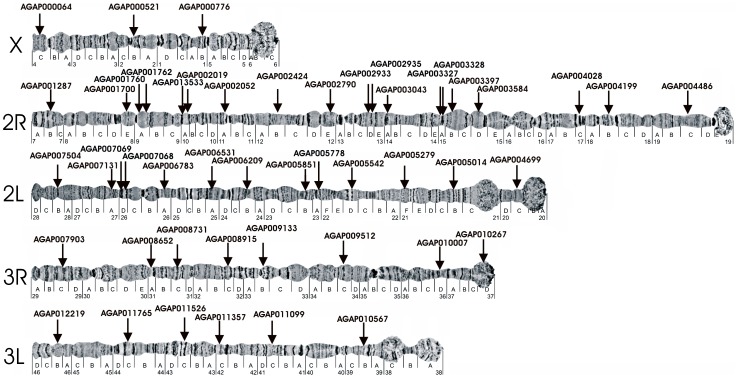
Distribution of genic phylogenetic markers in five chromosomal arms of An. gambiae.Names of the arms are placed near telomeres.